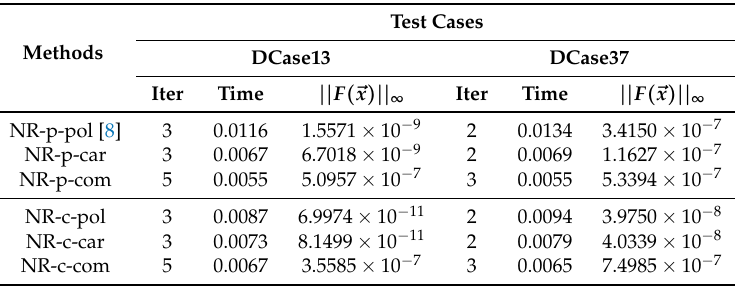
Table 4. Unbalanced distribution networks: DCase13 and DCase37.